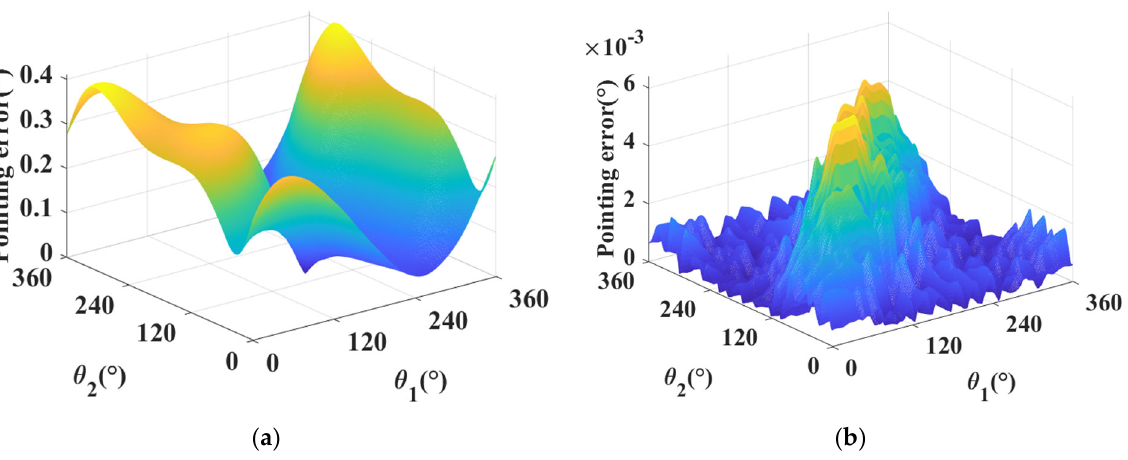
Figure 9. Simulation results of forward solution error correction. ( a ) Pointing error from forward solution before error fit. ( b ) Pointing error from forward solution after error fit. Table 3. Simulation results of forward solution error correction.